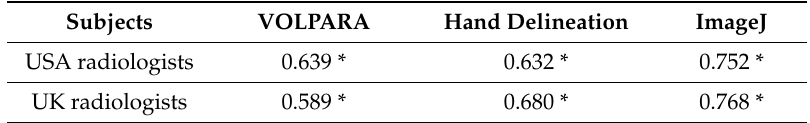
Table 3. The level of agreement using ( κ w) between USA and UK radiologists with Hand Delineation, ImageJ, and VOLPARA. Subjects VOLPARA Hand Delineation ImageJ USA radiologists 0.639 * 0.632 * 0.752 * UK radiologists 0.589 * 0.680 * 0.768 * * Statistical significance ( p < 0.001).